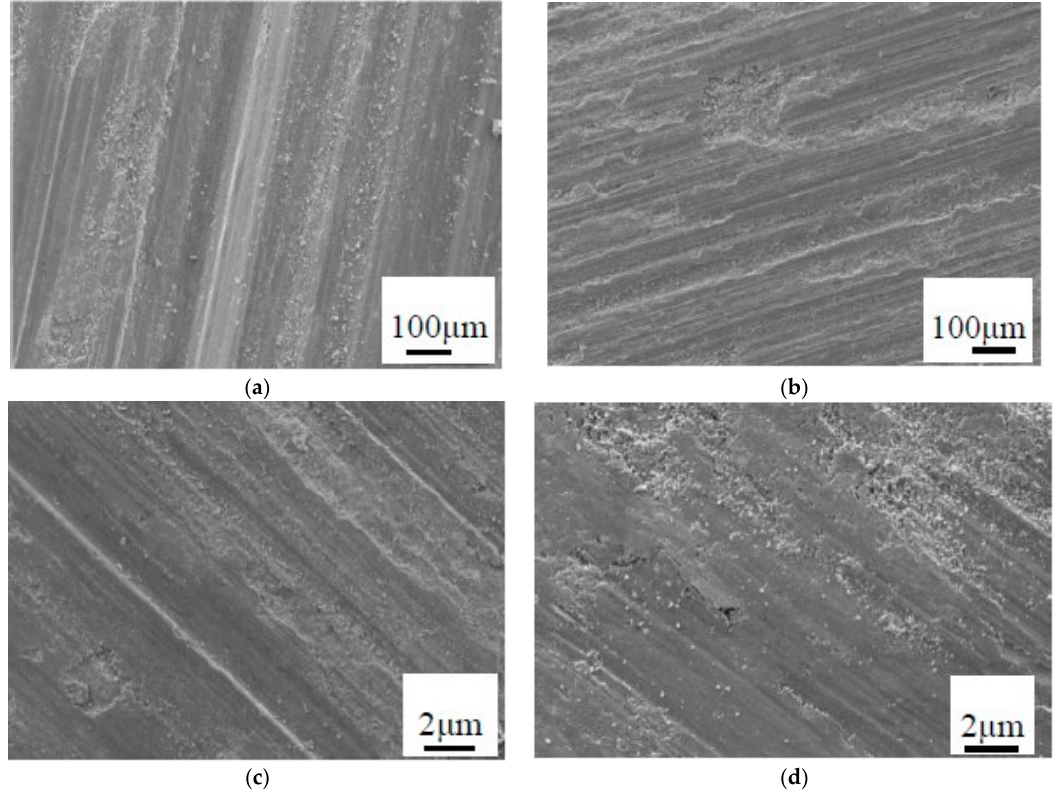
Figure 16. Wear morphology of N-SiCp/Al composite with different volume fraction under 4.5 GPa and 550 °C with 3 ( a ), 5 ( b ), 10 ( c ), 15 ( d ) vol.% N-SiCp.